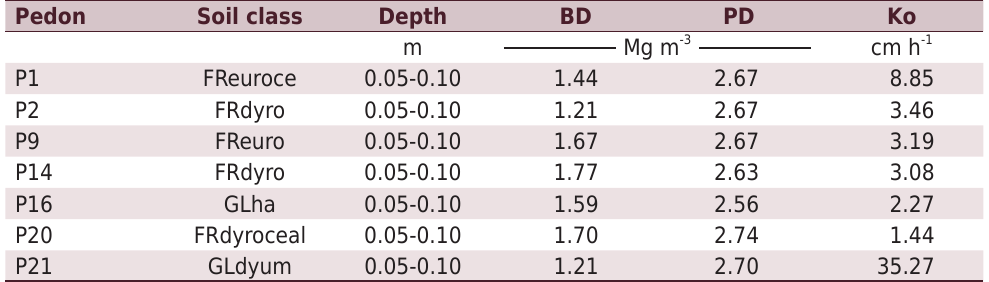
FReuroce: Eutric Rhodic Ferralsols (Clayic); FRdyro: Dystric Rhodic Ferralsols (Typical); FReuro: Eutric Rhodic Ferralsols (Typical); GLha: Haplic Gleysols (extra sample); FRdyroceal: Dystric Rhodic Ferralsols (Clayic, Alic); GLdyum: Dystric Umbric Gleysols. BD: bulk density (volumetric ring method); PD: particle density (volumetric flask method); Ko: hydraulic conductivity (constant head